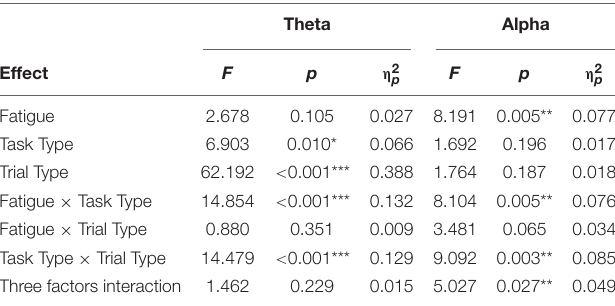
TABLE 4 | The 2 (Fatigue state: non-fatigue, fatigue) × 2 (Task Type: IT, ST) × 2 (Trial Type: pre-interruption, post-interruption) rm-ANOVA analyses results for theta and alpha